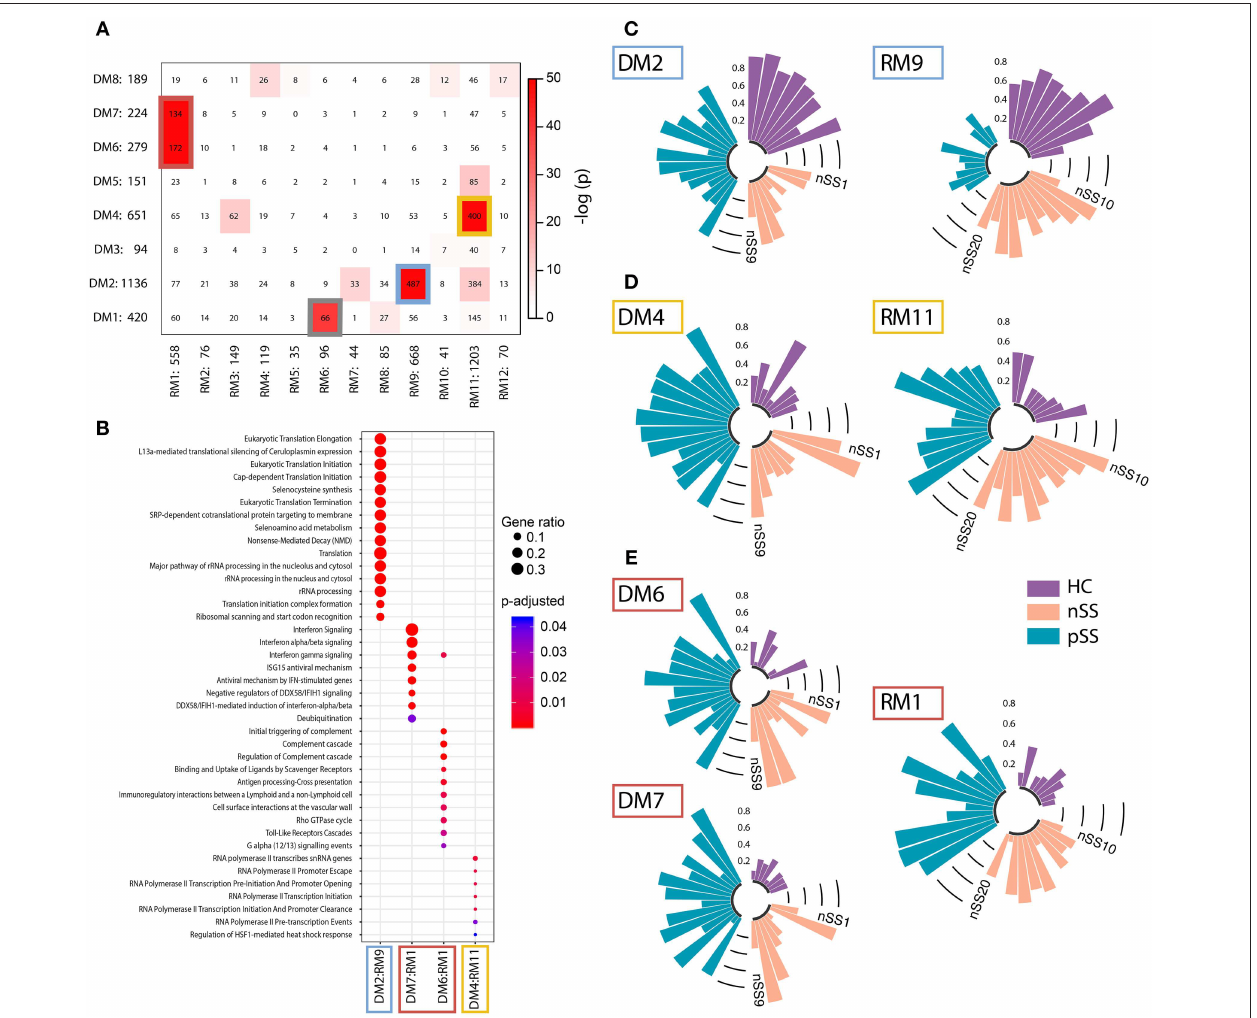
FIGURE 3 | Identification and functional annotation of replicated modules. WGCNA was performed to establish modules of co-expressed genes. To find the most robust and reproducible modules, the extent of overlap between the modules from the discovery and replication analysis was assessed. (A) depicts cross-tabulation of discovery modules (DM; rows) and replication modules (RM; columns). Each row and column is labeled by the corresponding module name and the number of replicated genes in the module. Within the table, numbers represent the count of genes present in the intersection of the corresponding row and column module. The table is color-coded by the Fisher exact test p -value. Five modules from the discovery cohort exhibited significant overlap with 4 modules from the replication cohort ( p < 10 − 20 ). The genes in these replicated modules were designated as gene signatures gray (DM1:RM6), blue (DM2:RM9), yellow (DM4:RM11), and red (DM6 + DM7:RM1). Go-term pathway enrichment was used for functional annotation of these signatures, there was no result for the gray signature. Dot-size depicts the fraction of the genes within the pathway that is enriched, color indicates p -value of the enrichment (B) . Eigengenes (the first principal component) of the blue (C) , yellow (D) , and red (E) signatures are depicted, each bar represents an individual donor and values are in the range [0, 1], where 0 represents the minimum and 1 represents the maximum value.